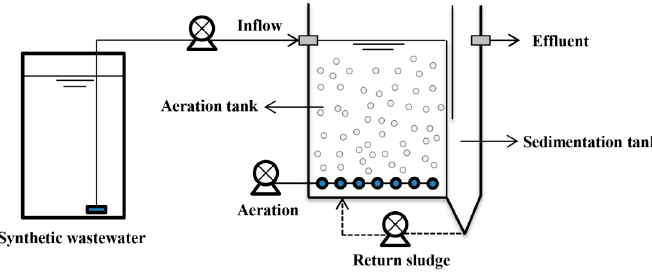
Figure 1. Schematic diagram of continuous-flow nitrifying activated sludge system.